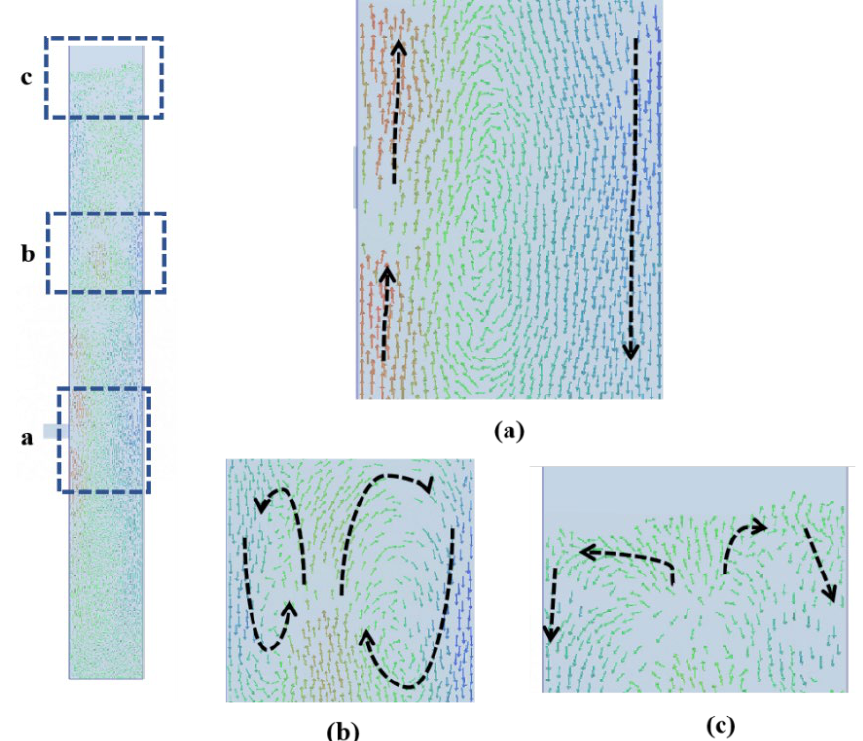
Figure 5. Instantaneous particle velocity vectors. ( a ) The velocity vector at feed pipe. ( b ) The velocity vector of the upper and middle sections of the fluidization section. ( c ) The velocity vector of top of the fluidized bed.